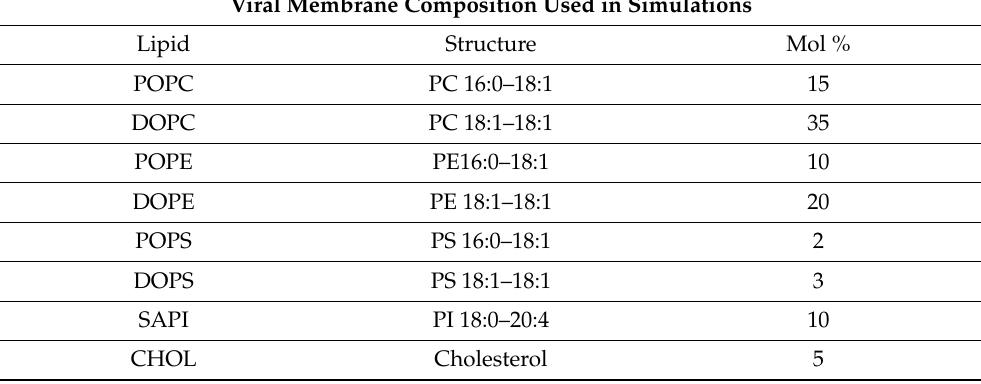
Table 2. The viral membrane composition used in simulations. Viral Membrane Composition Used in Simulations